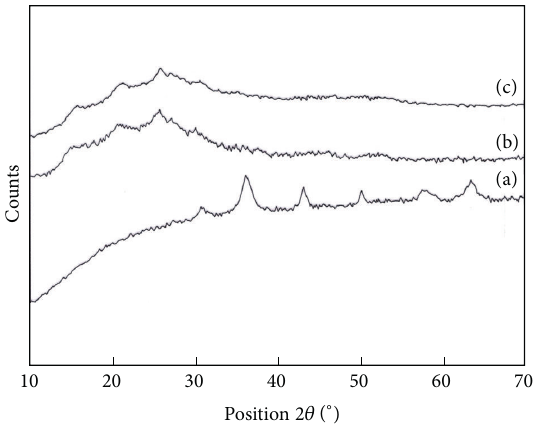
Figure 2: XRD patterns of (a) Fe 3 O 4 ferrite nanocrystals, (b) PANI, and (c) Fe 3 O 4 /PANI nanocomposites obtained from reverse